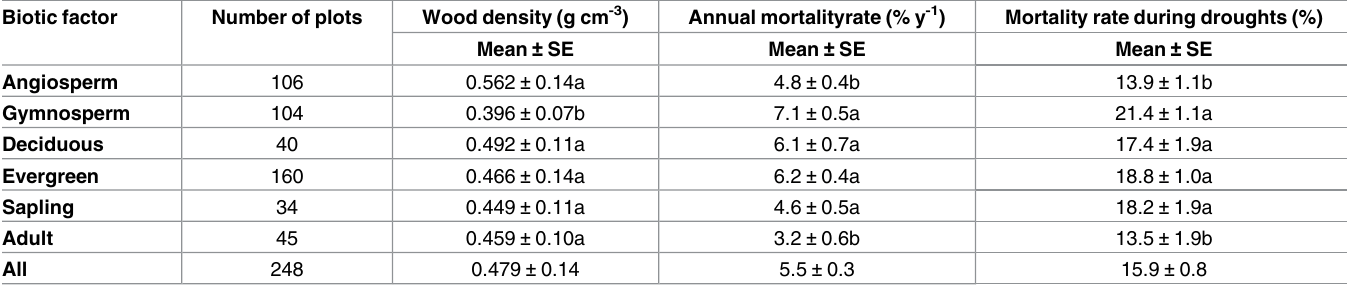
Table 1. Mean tree mortality rates and wood densities by tree group, forest type, and stand age. Significant differencesbetweenbiotic factors (angio- sperm or gymnosperm,deciduous or evergreen,saplingor adult) are labelledwith different lowercaseletters ( P < 0.05). Biotic